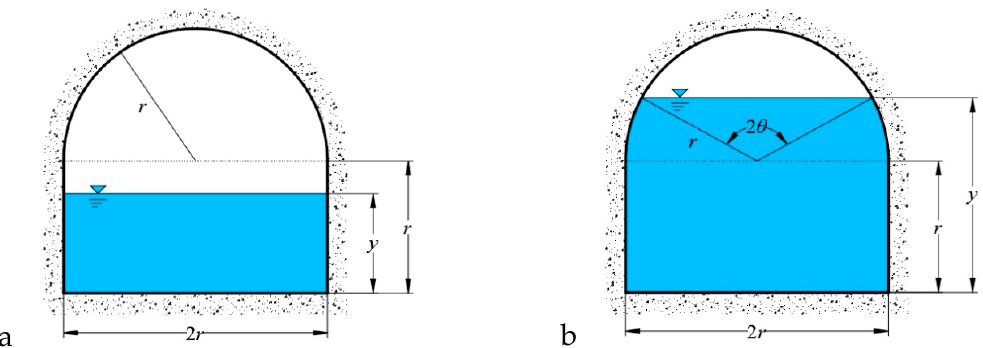
Figure 2. Cross-section of an arched conduit (( a ) 0 ≤ y ≤ r , ( b ) r ≤ y ≤ 2 r )).